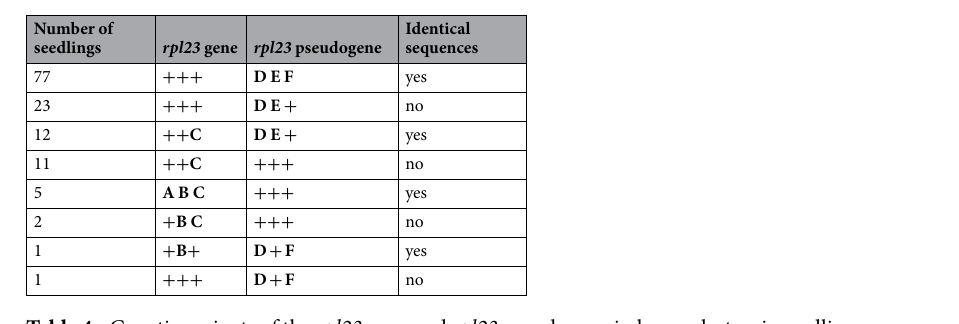
Table 4. Genetic variants of the rpl23 gene and rpl23 pseudogene in homoplastomic